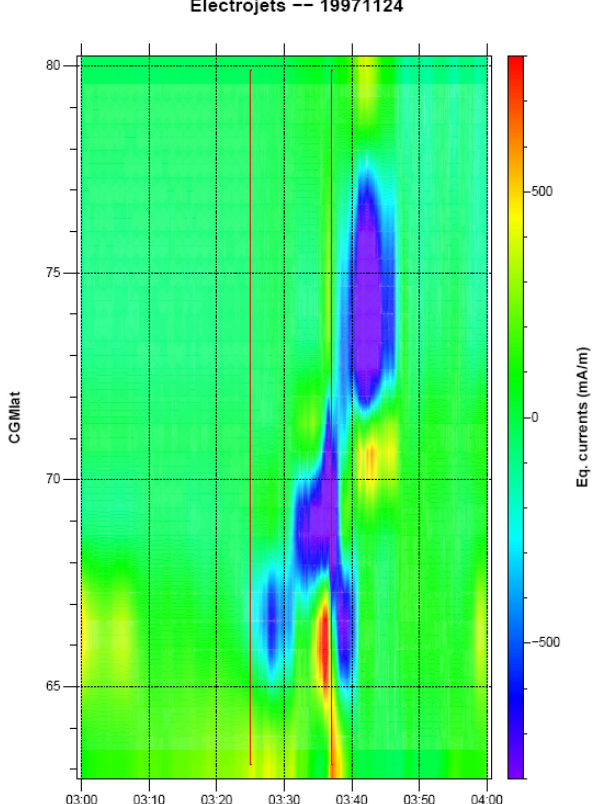
Fig. 5. Electrojet current densities (mA/m) deduced from the ground magnetic field measurements using the method of upward continuation by Amm et al. (1999). The electrojet is westward when the current is negative (blue), and eastward when the current is posi- tive (red). The vertical lines mark the times of the onset at 03:25 UT and the N-S aurora at 03:37